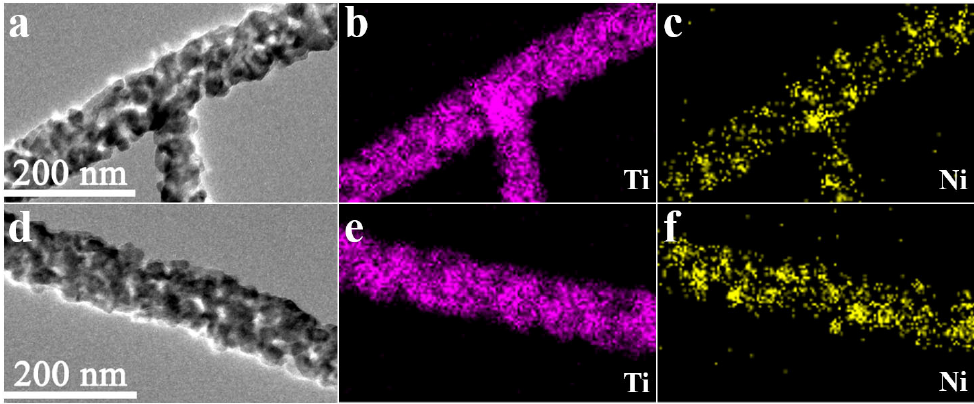
Figure 8. Elemental mapping images of ( a – c ) 3 wt.% Ni-doped TiO 2 nanofibers and ( d – f ) 6 wt.% Ni-doped TiO 2 nanofibers.